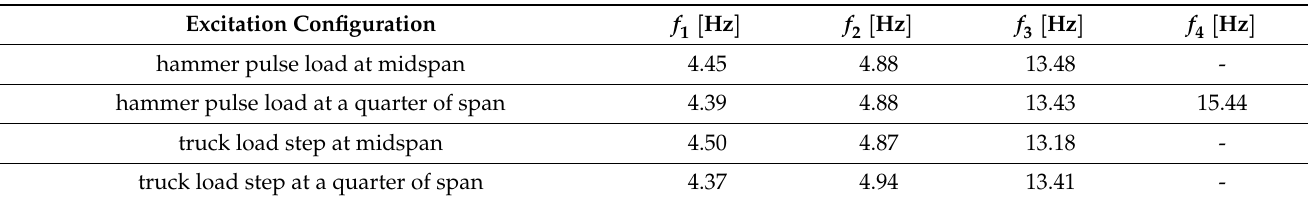
Table 1. Identified natural frequencies from OMA related to different excitation configurations before static load tests.